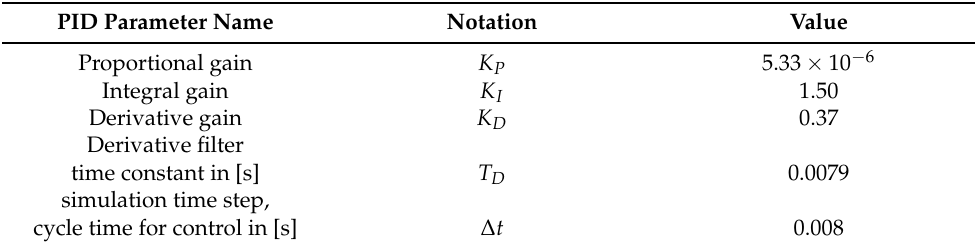
Table 3. Values of the tuned PID parameters used in “PID with nonlinear feedforward” con- trol